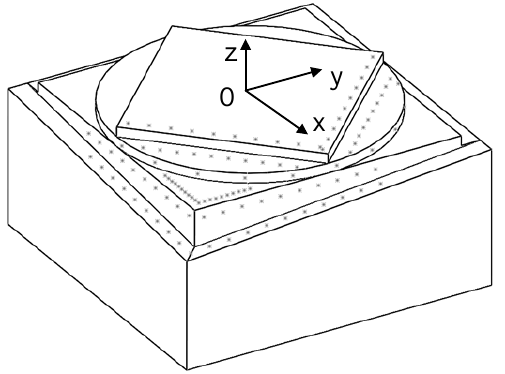
Figure 10. Simulation points on the NAS piece.